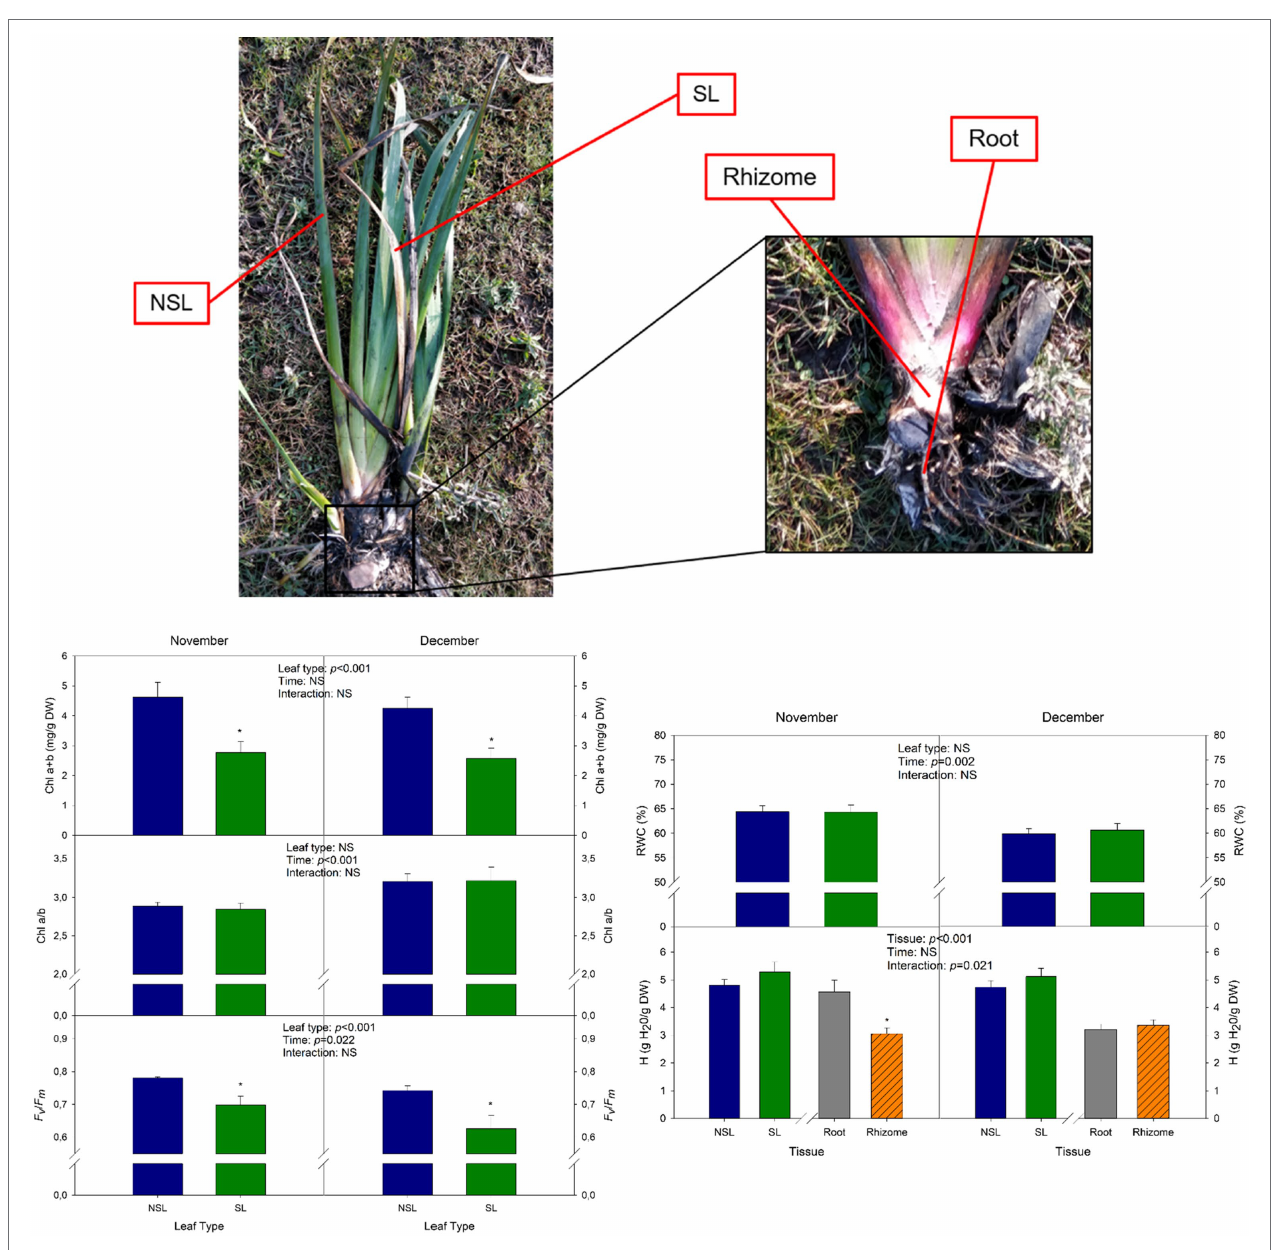
FIGURE 2 | Cold stress-induced leaf senescence in Iris pseudacorus individuals at the start of winter. Phenotype of senescent leaves (SLs) and non-senescent leaves (NSLs) sampled in this study, with a close-up of a rhizome and the root system of I. pseudacorus . Total chlorophyll contents (Chl a + b), chlorophyll a-to-b ratio (Chl a/b), and maximum efficiency of PSII ( Fv/Fm ) of SL and NSL leaves sampled in November and December. The relative water content (RWC) of SLs and NSLs, and the hydration (H) of SLs, NSLs, roots, and rhizomes are also shown. Values of p from the two-way mixed factorial analysis are shown in the inlets, including the factor Time , Leaf type/Tissue , and their interaction. An asterisk indicates differences between leaf types or root tissue types. Data show the mean ± SE of n = 12 individuals. NSL, non-senescent leaf; SL, senescent